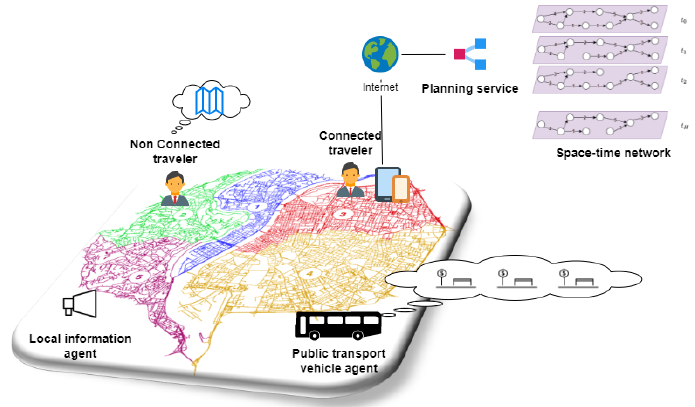
Figure 4. Architecture of the multi-agent